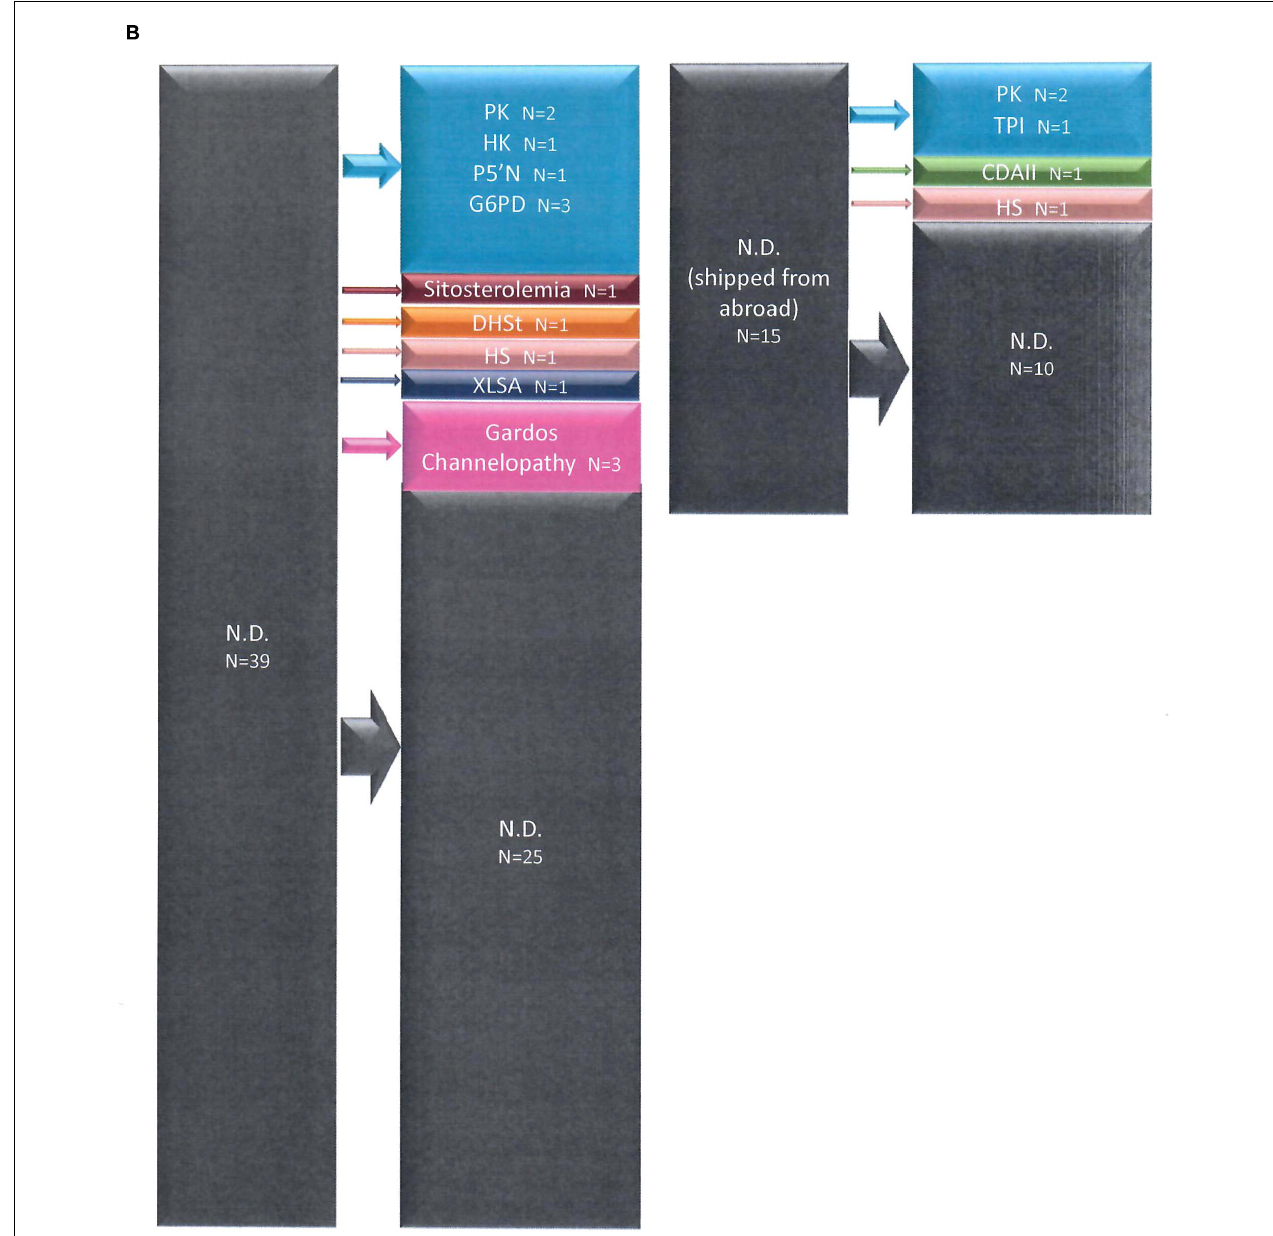
FIGURE 1 | Diagnostic suspect after first and second level laboratory investigation and final diagnosis after t-NGS in Group 1 (A) and Group 2 (B)